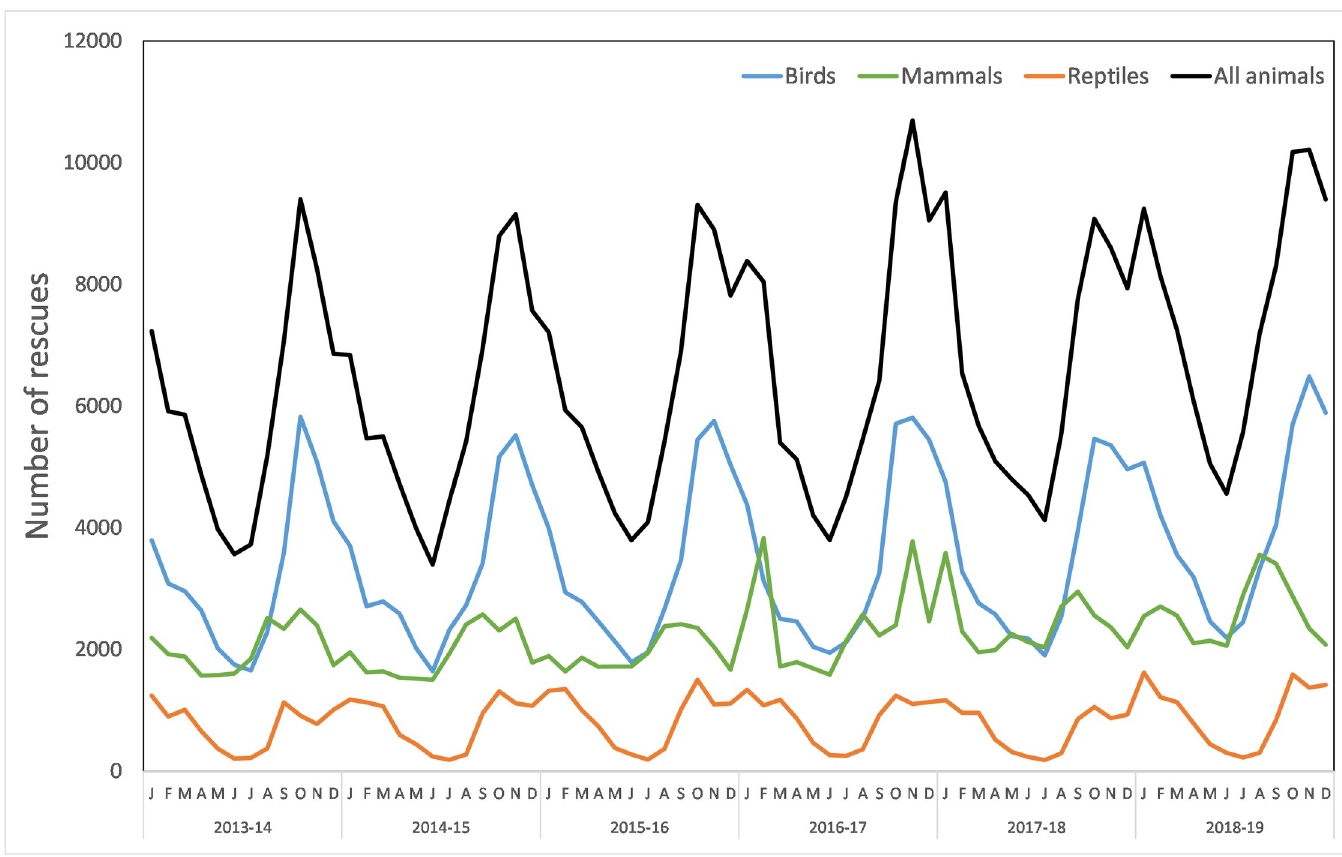
Fig 6. Number of records per year over the survey period, for birds, reptiles, mammals, and all